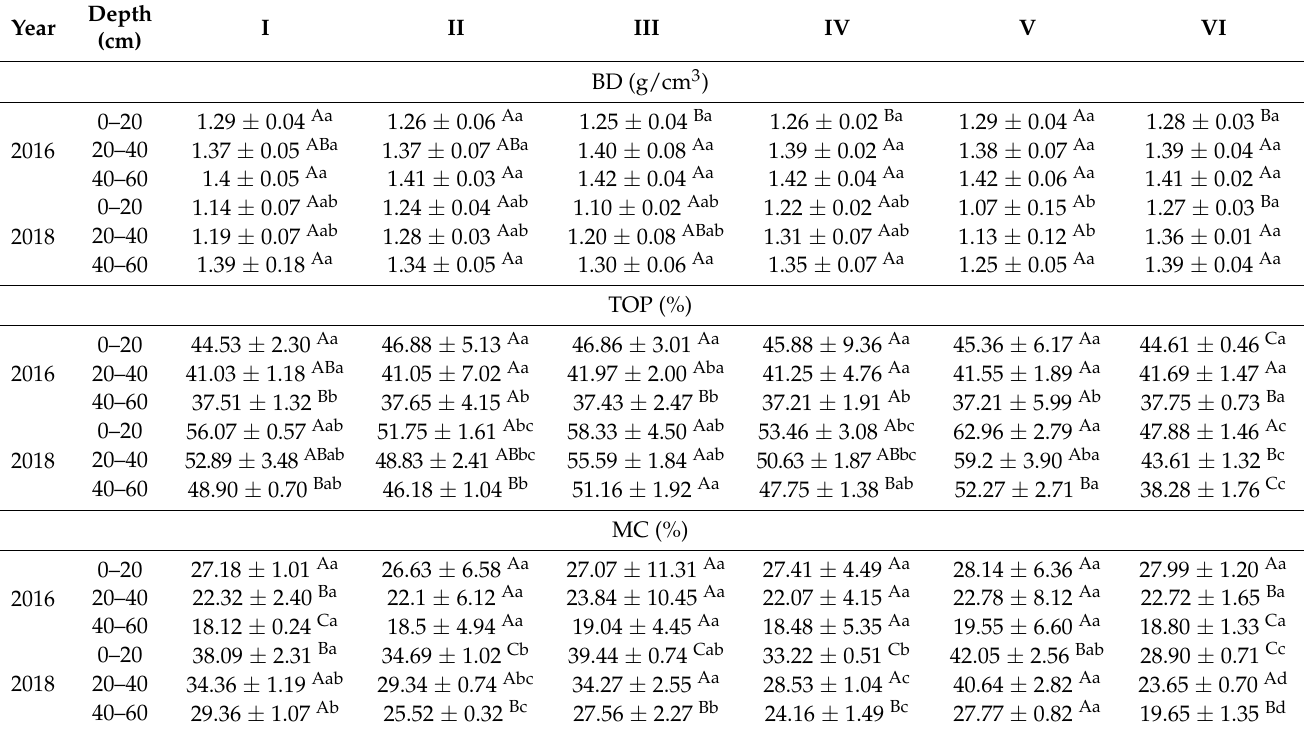
Table 2. Description of soil physical properties under six forest stands at 0–20, 20–40 cm, and 40–60 cm (mean ± stand error, n =